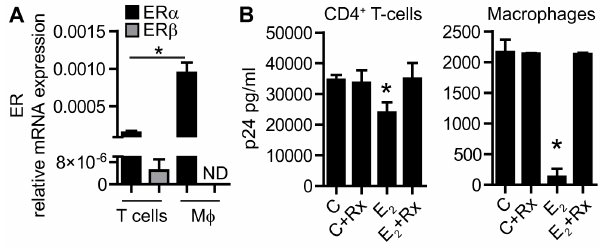
Figure 7. Role of estrogen receptor in E 2 -mediated suppression of HIV-infection. A) Expression of ER a (black bars) and ER b (grey bars) detected by real time RT-PCR in CD4 + T-cells (N=3) and macrophages (N=4). Bars represent mean 6 SEM from 3 and 4 different donors for CD4 + T-cells and macrophages respectively. ND: non-detected. B) Released p24 detected by ELISA in the culture media of CD4 + T-cells and macrophages after 7 days of infection. Bars represent mean 6 SEM from 4 replicates. Representative of 3 independent experiments. Rx: Raloxifene. *P , 0.05.